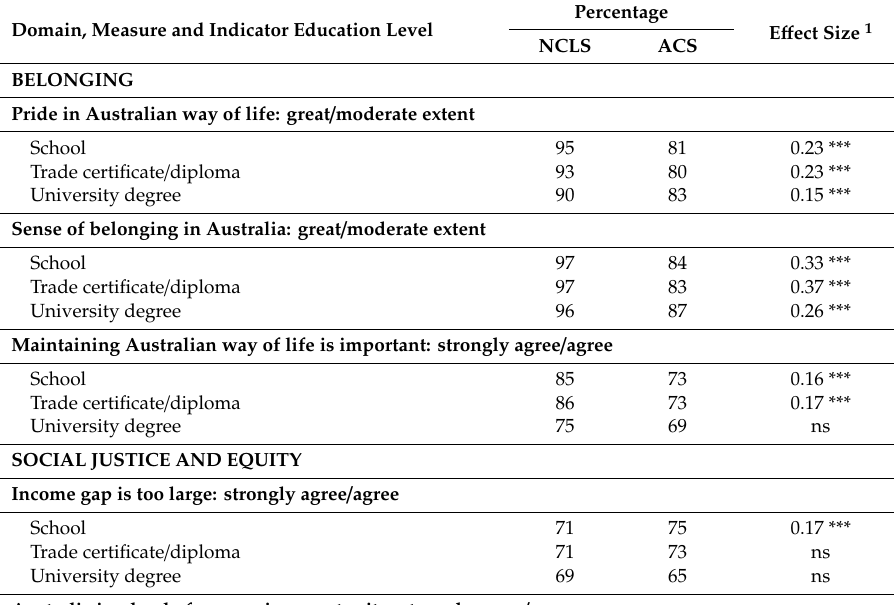
Table A4. Social cohesion indicators, NCLS versus ACS by education